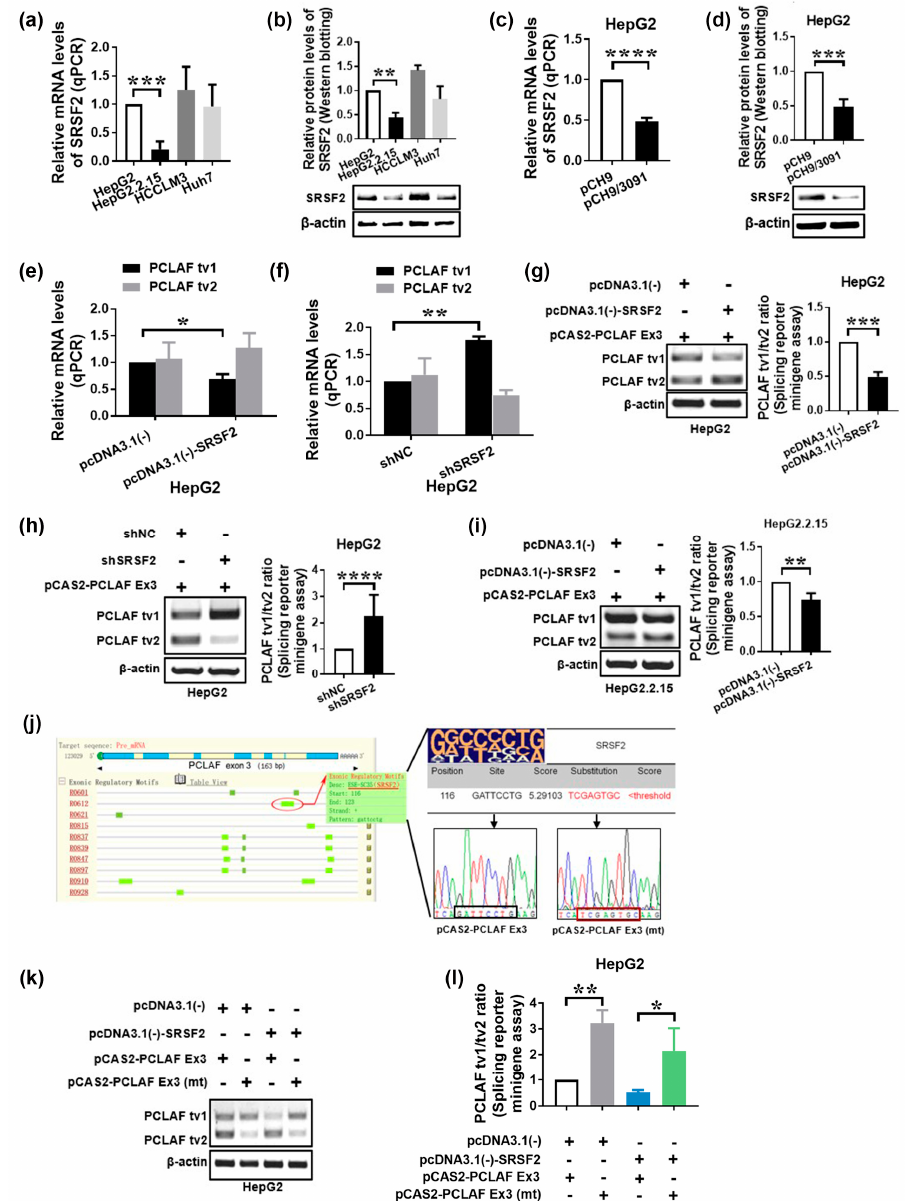
ferrostatin-1, a lipid peroxidation inhibitor, suppressed sorafenib’s regulation of SLC7A11 and ACSL4 expression ( p < 0.05; Figure 4b). TfR1 expression was also upregulated by sorafenib and suppressed by ferrostatin-1 therapy, as shown in Figure 4c. These findings imply that sorafenib has an anticancer impact on HCC via ferroptosis.